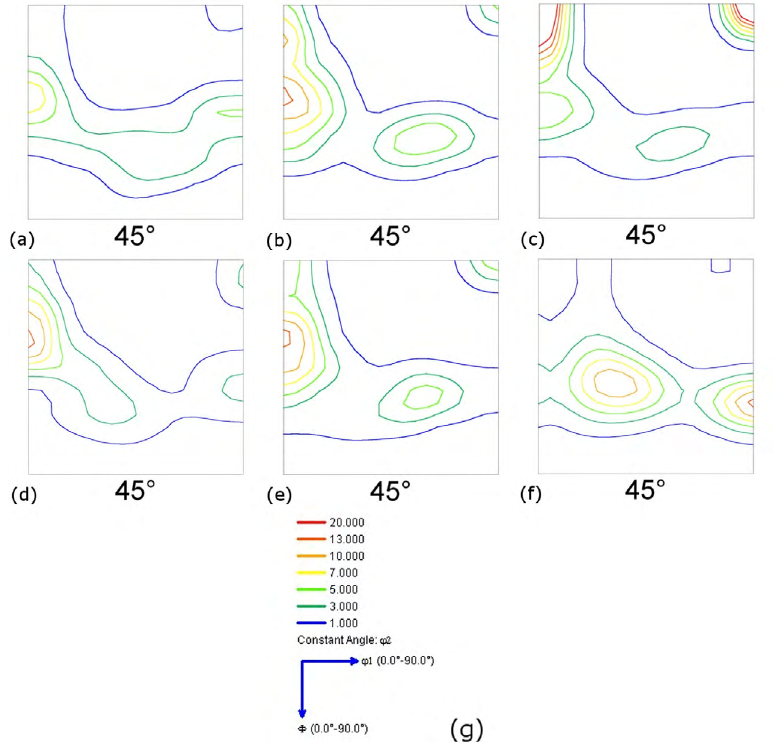
Figure 8. ODFs maps for specimens of the ASTM 439 steel at conditions (a)CR, (b)T1, (c)T2, (d)T4, (e)T5 and (f)A, respectively. (g) levels. Constant sections of